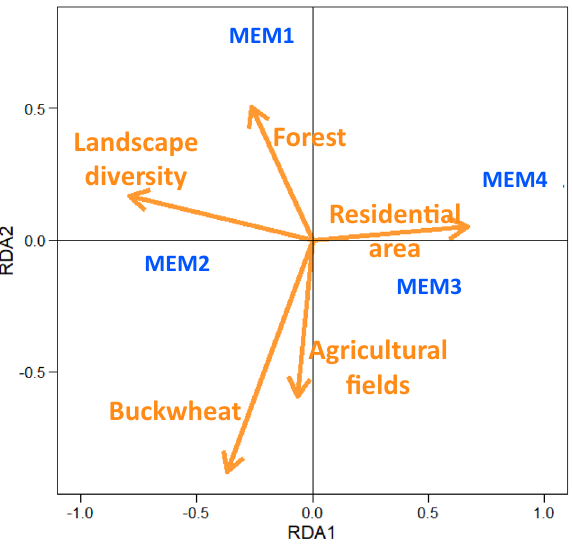
Figure 1. Results of RDA relating four spatial variables (MEMs: Moran’s Eigenvector Map) to five landcover variables, as represented by the two RDA axes. MEM scores were used as response variables and a set of landcover variables were used as explanatory variables (area proportions of 5 land cover types and landscape diversity (Shannon diversity index)). Arrows represent the vector of land cover variables, and the plotted texts (MEM1 ~ 4) indicate the locations of MEMs.